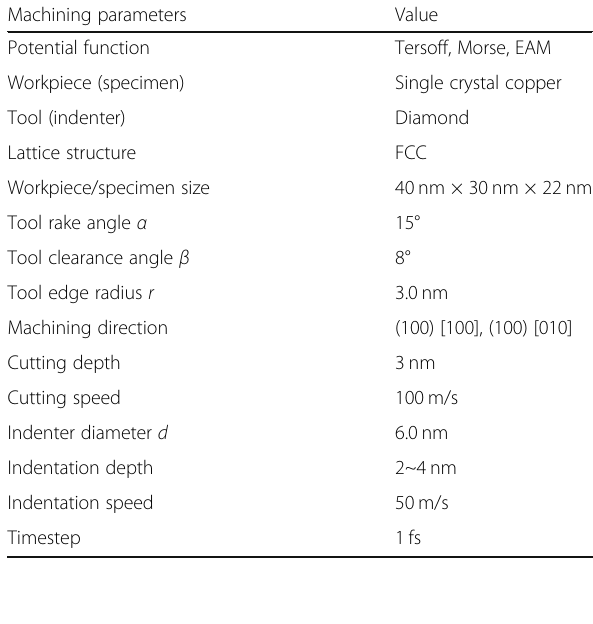
Table 1 MD simulation conditions in 3-D nano-machining Machining parameters